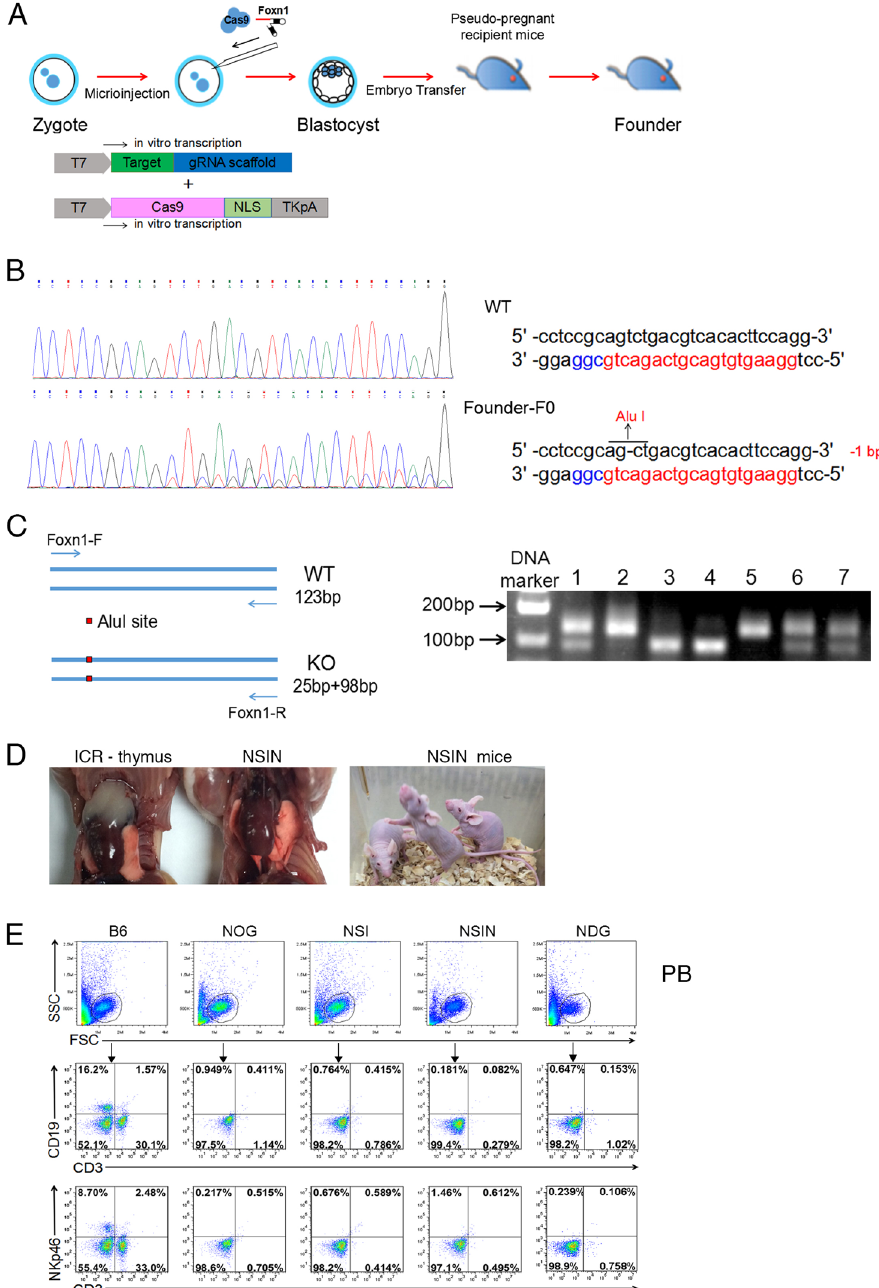
Figure 2. Generation and characterization of Foxn1-deleted NSIN mice. ( A ) Schematic of the generation of NSIN mice. Cas9 mRNA and gRNA were co-injected into the cytoplasm of pronuclear-stage mouse embryos. The injected embryos were then transferred into pseudo-pregnant surrogate mothers. The mouse pups were genotyped and screened for Foxn1 mutations. The in vitro transcription of both vectors was controlled by T7 promoters. ( B ) Sequence analysis of the founder mice. The target exon 1 of Foxn1 was amplified using PCR and then analyzed by DNA sequencing. The PCR products were 644 bp long. The wild-type (WT) sequence of Foxn1 is shown at the top of the figure. Double sequencing peaks indicate the presence of mutant alleles in the somatic cells of the mice. The targeting and PAM sequences are labeled in red and blue, respectively. A new AluI enzyme locus was generated by deleting a thymidine residue. ( C ) PCR genotyping of the F2 generation offspring. Primers were designed to amplify 123-bp PCR products spanning the mutation site. The PCR products were digested using the Alu I enzyme. The results from seven offspring mice are shown: WT NSI (lanes 2 and 5), Foxn1 + / − NSI (lanes 1, 6, and 7), and Foxn1 − / − NSI (NSIN) mice (lanes 3 and 4). ( D ) Photographs of thymi of ICR and NSIN mice. ( E ) Flow cytometric analysis indicating the absence of B, T, and NK cells in the peripheral blood (PB) of B6, NOG, NSI, NSIN, and NDG mice. Cells were gated from FSC/SSC for the detection of T, B, and NK cells. C57BL/6J (B6) mice were used as a positive